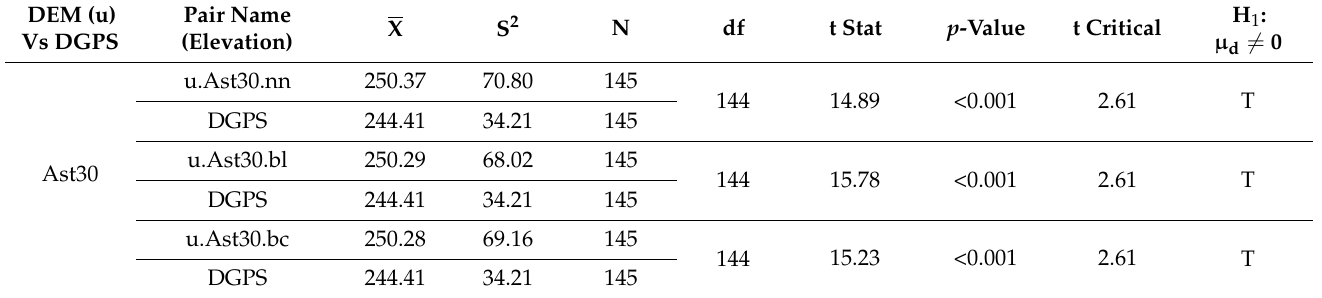
Table 8. Results of two-tail paired t -test for mean of elevation (Z) values (at 99% CL & α = 0.01) carried out taking pairs of elevation values observed by “DGPS” and sampled over “uncorrected (u)” DEM rasters, where values were extracted by three interpolation methods: nearest neighbour (nn), bilinear (bl), and bicubic (bc) at